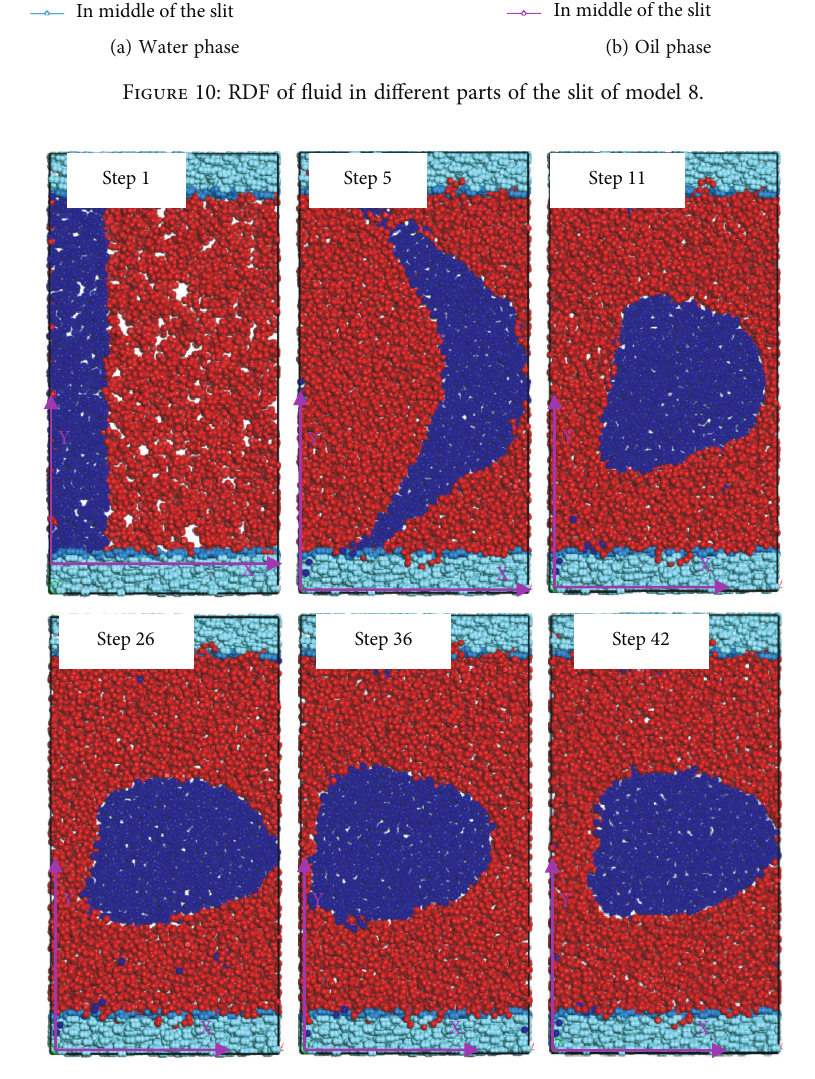
Figure 11: Section of the slits of model